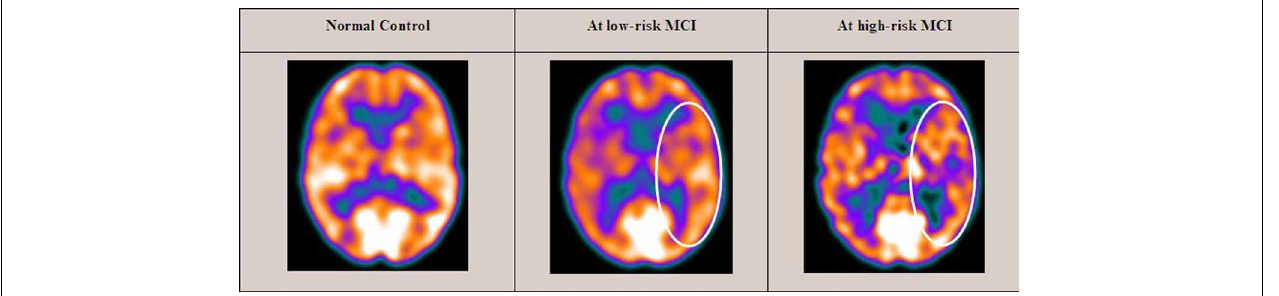
FIGURE 1 | SPECT visual rating. The output shows a SPECT visual inspection of glucose uptake metabolism: the white square denotes an area of mild-to-moderate (purple to blue) temporparietal